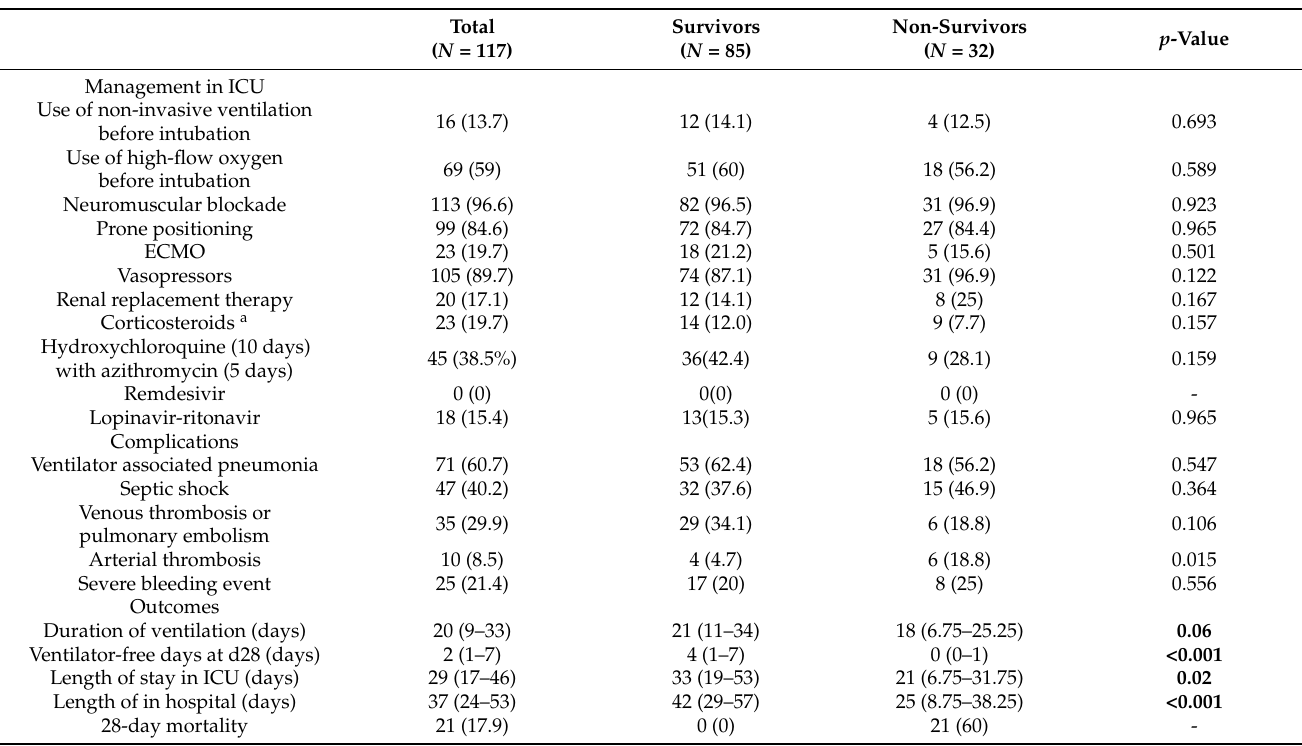
Table 2. Management, complications and outcomes of the 117 patients on invasive mechanical ventilation according to their 90-day survival